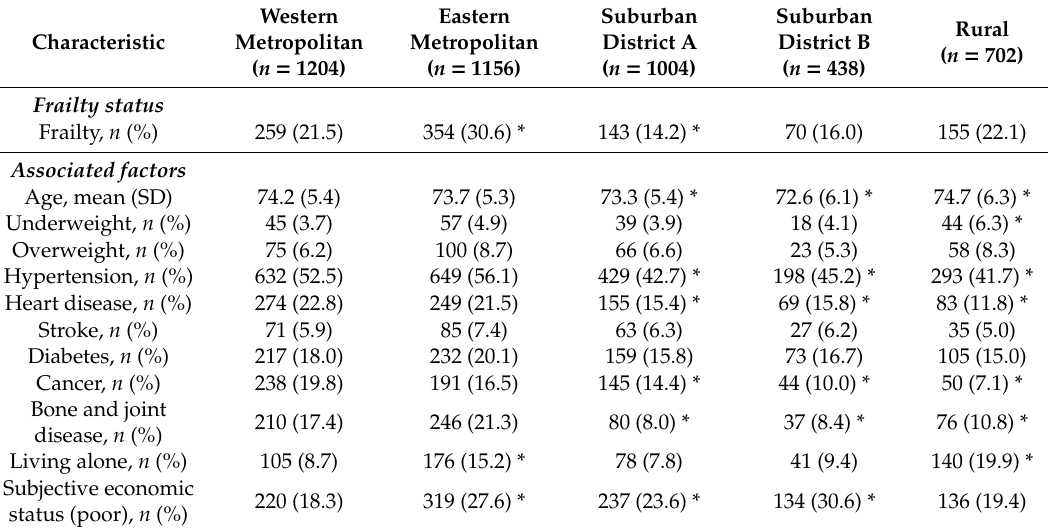
Table 1. Characteristics of men in each area.